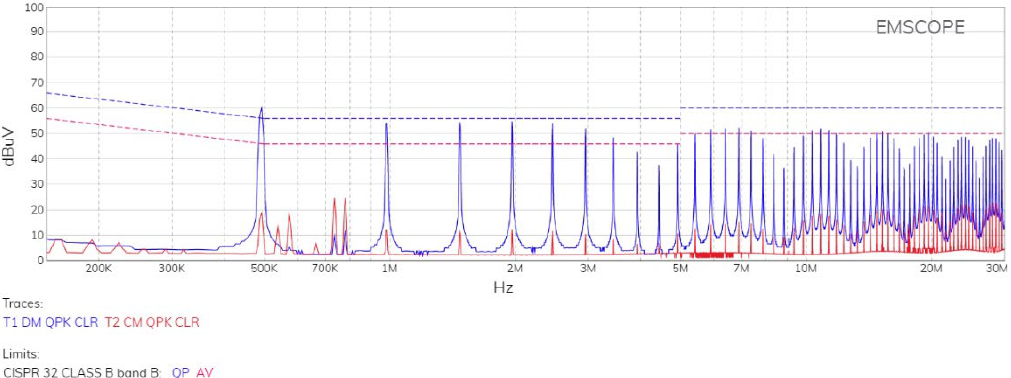
Figure 14. CE measurement at the positive terminal (‘+’) of the Boost converter using the quasi-peak (QPK, blue) and average (AVG, red) detectors. Amplitude units are in dBµV, and Frequency units are in Hz.